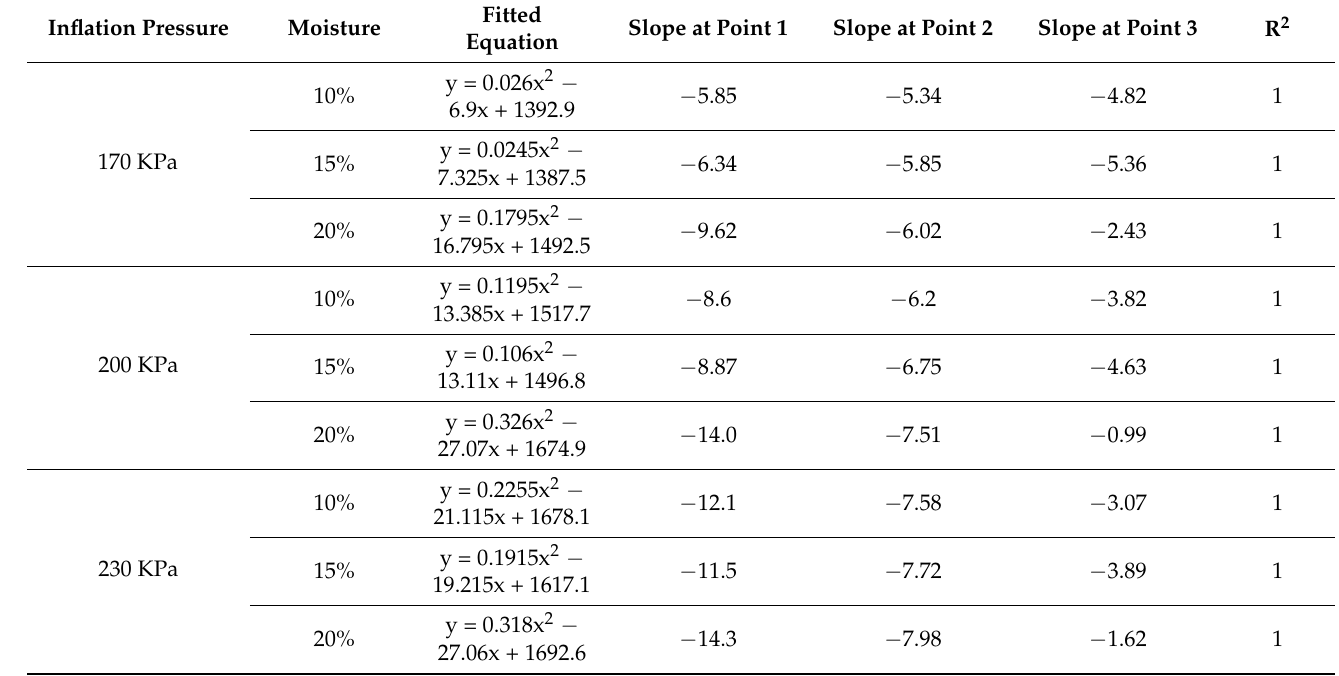
Table 4. Equations that fitted the curve bulk density relative to the depth, moisture (d.b.) and inflation